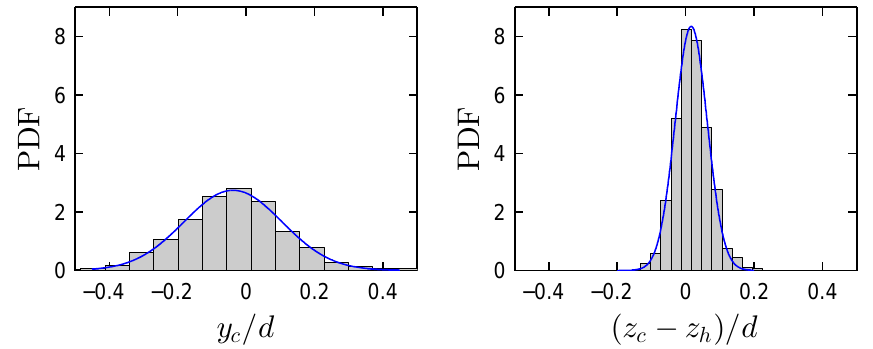
Figure 16. Probability density function (PDF) of the wake-center position in both lateral and vertical directions at x / d = 6. The blue curves show the fitted normal distributions.